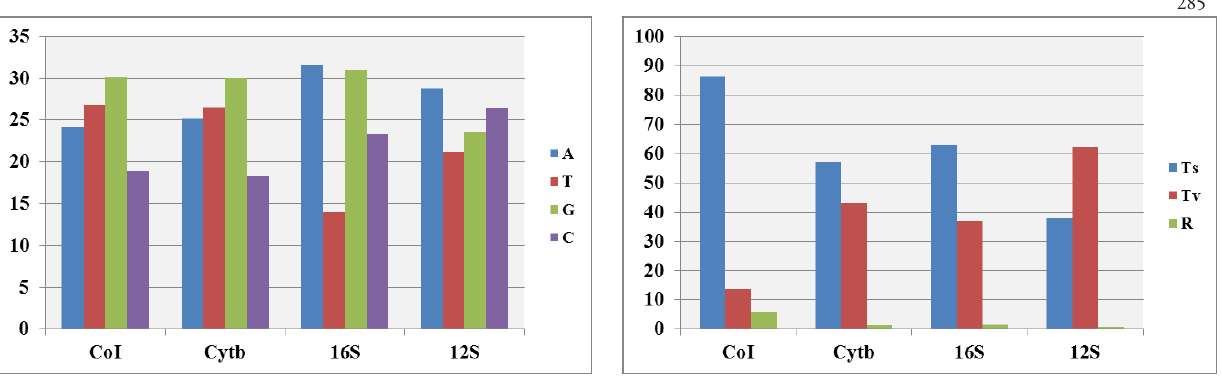
drial genes of Elops species